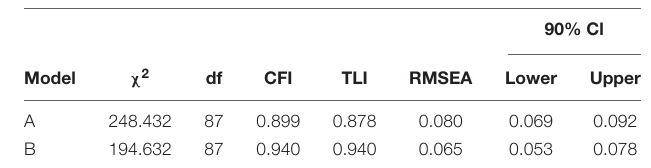
TABLE 2 | Fit Indices on ABQ and